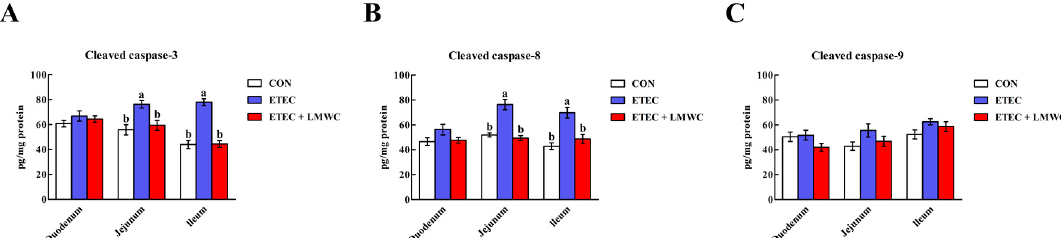
Figure10. E ff ectsoflow-molecular-weightchitosanonthecleavedcaspasecontentsinthesmallintestine of weaned pigs challenged with enterotoxigenic Escherichia coli . ( A ) Cleaved caspase-3, cleaved cysteinyl aspartate-specific protease-3. ( B ) Cleaved caspase-8, cleaved cysteinyl aspartate-specific protease-8. ( C ) Cleaved caspase-9, cleaved cysteinyl aspartate-specific protease-9. a, b Means with di ff erent letters on vertical bars indicate significant di ff erences ( P < 0.05). Values are means ( n = 8 pigs / treatment), with standard errors represented by vertical bars. CON: non-infected control (pigs received the basal diet and infused with sterilised Luria–Bertani culture); ETEC: ETEC-infected control (pigs received the basal diet and infused with enterotoxigenic Escherichia coli ); ETEC + LMWC: pigs received the basal diet supplemented with 100 mg / kg low-molecular-weight chitosan and infused with enterotoxigenic Escherichia coli